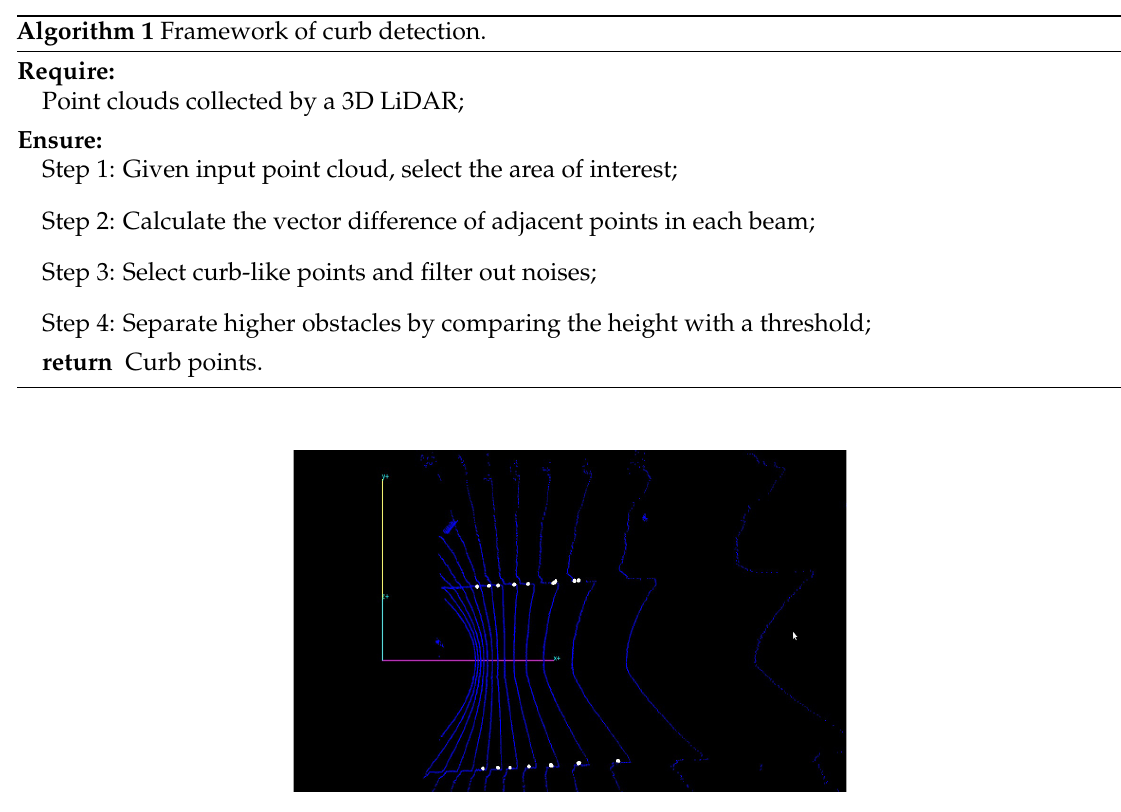
Figure 5. Output to the curb detection